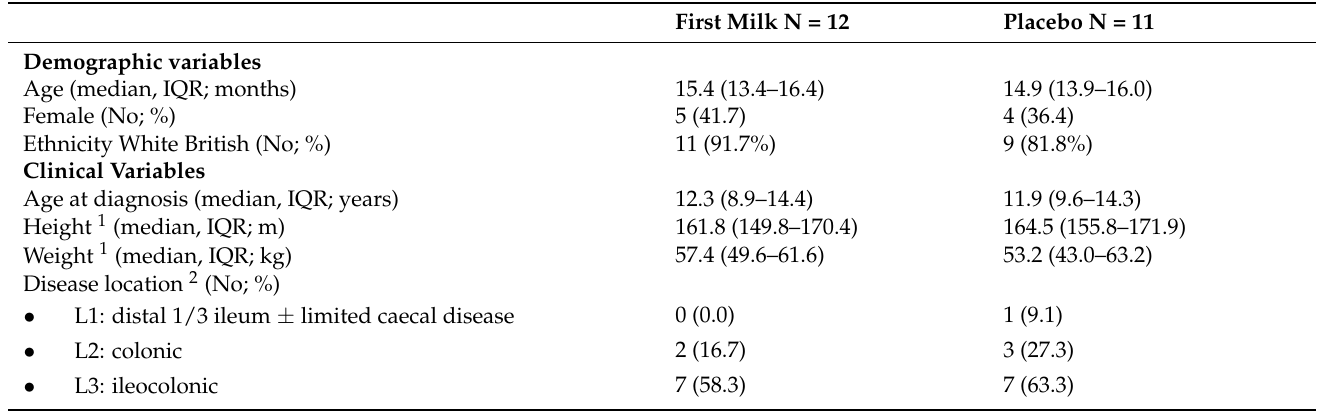
Table 1. Demographic and clinical variables at recruitment according to intervention